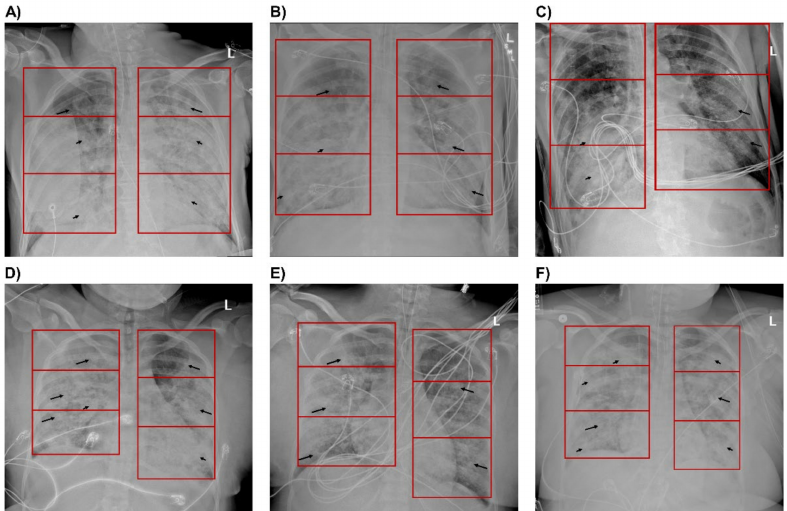
Figure 4. Chest X-rays of patients with sustained improvement in PaO 2 / FiO 2 and with decline in PaO 2 / FiO 2 after 48 hours (h). Anterior-Posterior (AP) radiographs of the chest with lung zones demarcated by a red box. Images ( A – C ) are from a single patient with sustained improvement in PaO 2 / FiO 2 . Images ( D – F ) are from a single patient with a decline in PaO 2 / FiO 2 . ( A ) Image captured 48 h before proning demonstrates ground-glass opacities in the left and right upper lung zones (long arrows), with confluent consolidations in the right middle, right lower, left middle, and left lower zones (short arrows). Images ( B ) immediately after proning demonstrate improving infiltrates bilaterally with significant improvement in the left middle, left lower, and right lower lung zones, and ( C ) 48 h after proning demonstrate significant improvement in the infiltrates bilaterally with residual dense consolidation in the right middle and lower lung zones. ( D ) Image one day before proning demonstrates ground-glass opacities throughout all lung zones (long arrows), with di ff usely scattered confluent consolidations bilaterally (short arrows). Images ( E ) immediately after proning demonstrate improving infiltrates, particularly in the right upper, left upper, and left middle lung zones, and ( F ) 48 h after proning demonstrate worsening of infiltrates bilaterally with increased confluent consolidations in the left and right upper lung